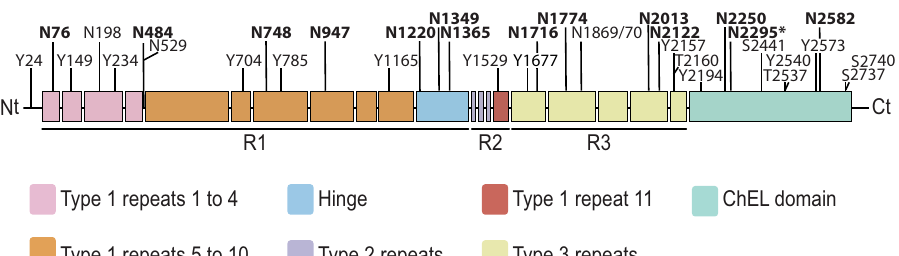
Fig. 1 The cryo-EM map of hTG at 3.2 Å. (Right) Density map of hTG with one monomer in white and corresponding atomic model (left). Map and model are colored as in the bottom linear diagram of the primary structure of